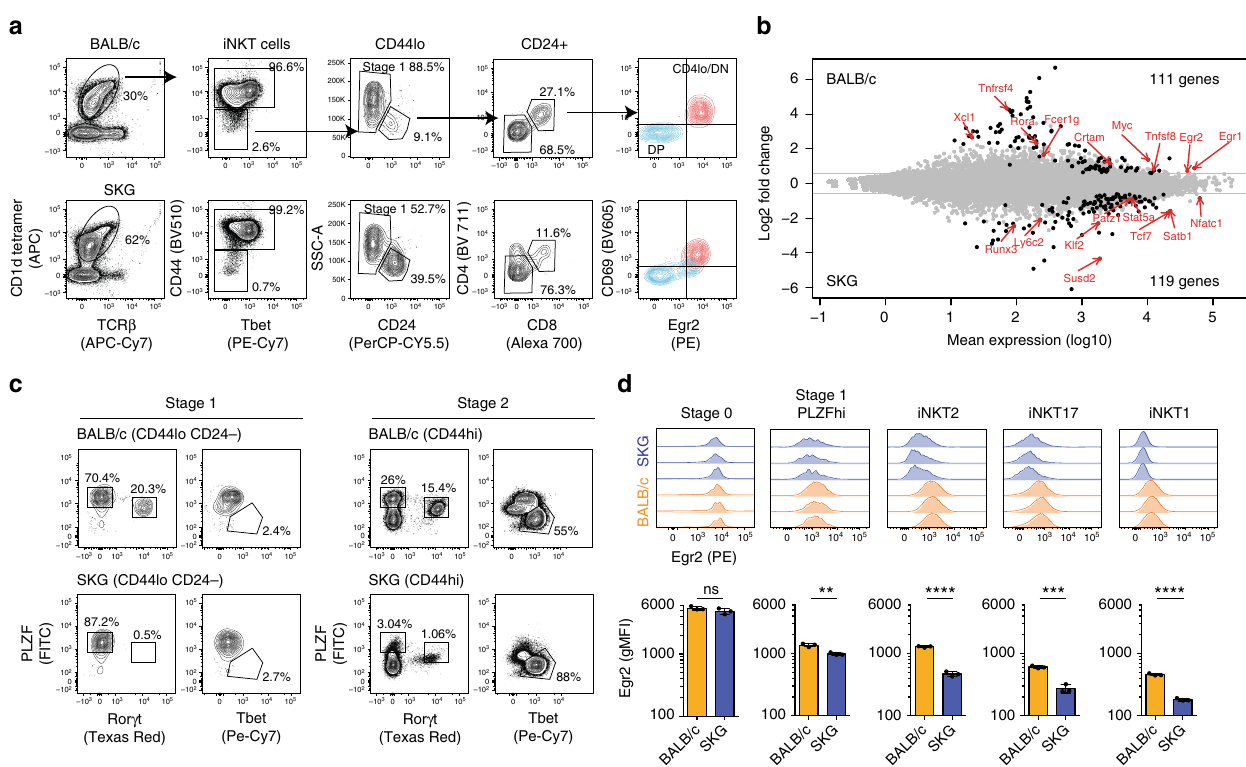
Fig. 5 Differential gene expression in iNKT cells of BALB/c and SKG mice. a Gating strategy used to identify and sort stage 0 iNKT cells in BALB/c (top) and SKG (bottom) mice. Enrichment of iNKT cells from the thymi of BALB/c or SKG mice was achieved after staining with APC-labeled PBS57 – CD1d tetramer and enrichment using anti-APC magnetic beads. Stage 0 iNKT cells were de fi ned as TCR β + PBS57 – CD1d tetramer + CD44 − CD24 + CD4 lo CD8 − CD69 + . As seen on the fi gure, these cells are also Egr2 + (red) in contrast with the CD4 + CD8 + (blue) population that invariably contaminates the cell preparation. b Mean average plot of genes expressed differentially in stage 0 iNKT cells isolated from SKG mice relative to their expression in such cells from BALB/c control mice. Data are representative of one experiment with three biological replicates per genotype. 238 genes (displayed in black) were found to be differentially expressed >1.5-fold with a false discovery rate <0.1. c Analysis of transcription factor (PLZF, Ror γ t, and Tbet) expression in stage 1 (CD44 − CD24 − ) and stage 2 (CD44 + ) iNKT cells from the thymi of BALB/c and SKG mice. Data are representative of >5 mice analyzed for each genotype. d Analysis of Egr2 expression level in BALB/c (orange) and SKG (purple) iNKT cells at different developmental stages. Results from three mice of each genotypes analyzed independently are shown. The mean ± SD of Egr2 gMFI in each iNKT cell developmental stage in BALB/c and SKG mice is shown. Signi fi cance was assessed using the unpaired t -test. ** p < 0.01; *** p < 0.001; **** p < 0.0001; ns, not signi fi